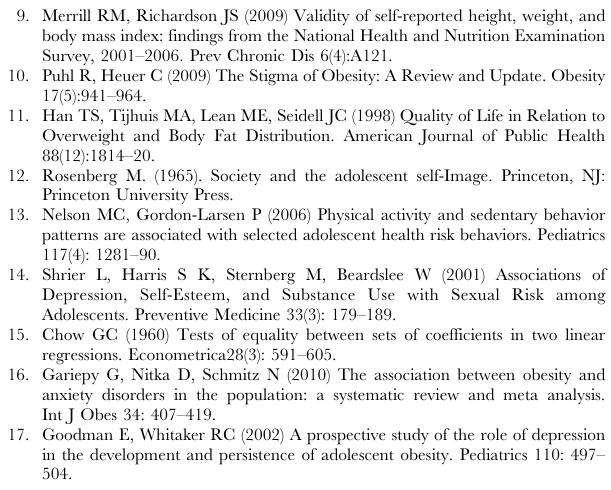
Wave II Reported